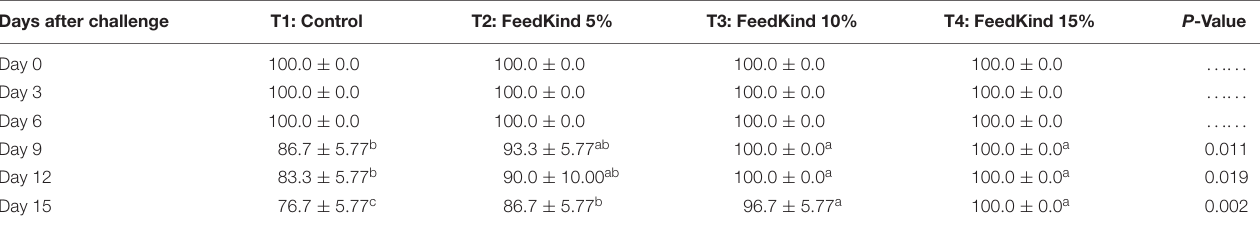
TABLE 5 | Survival rate of white shrimp following immersion challenge by V. parahaemolyticus (AHPND) at 5.8 × 10 4 CFU/ml for 15 days after being fed different levels of methanotroph bacteria meal diets for 6 weeks.